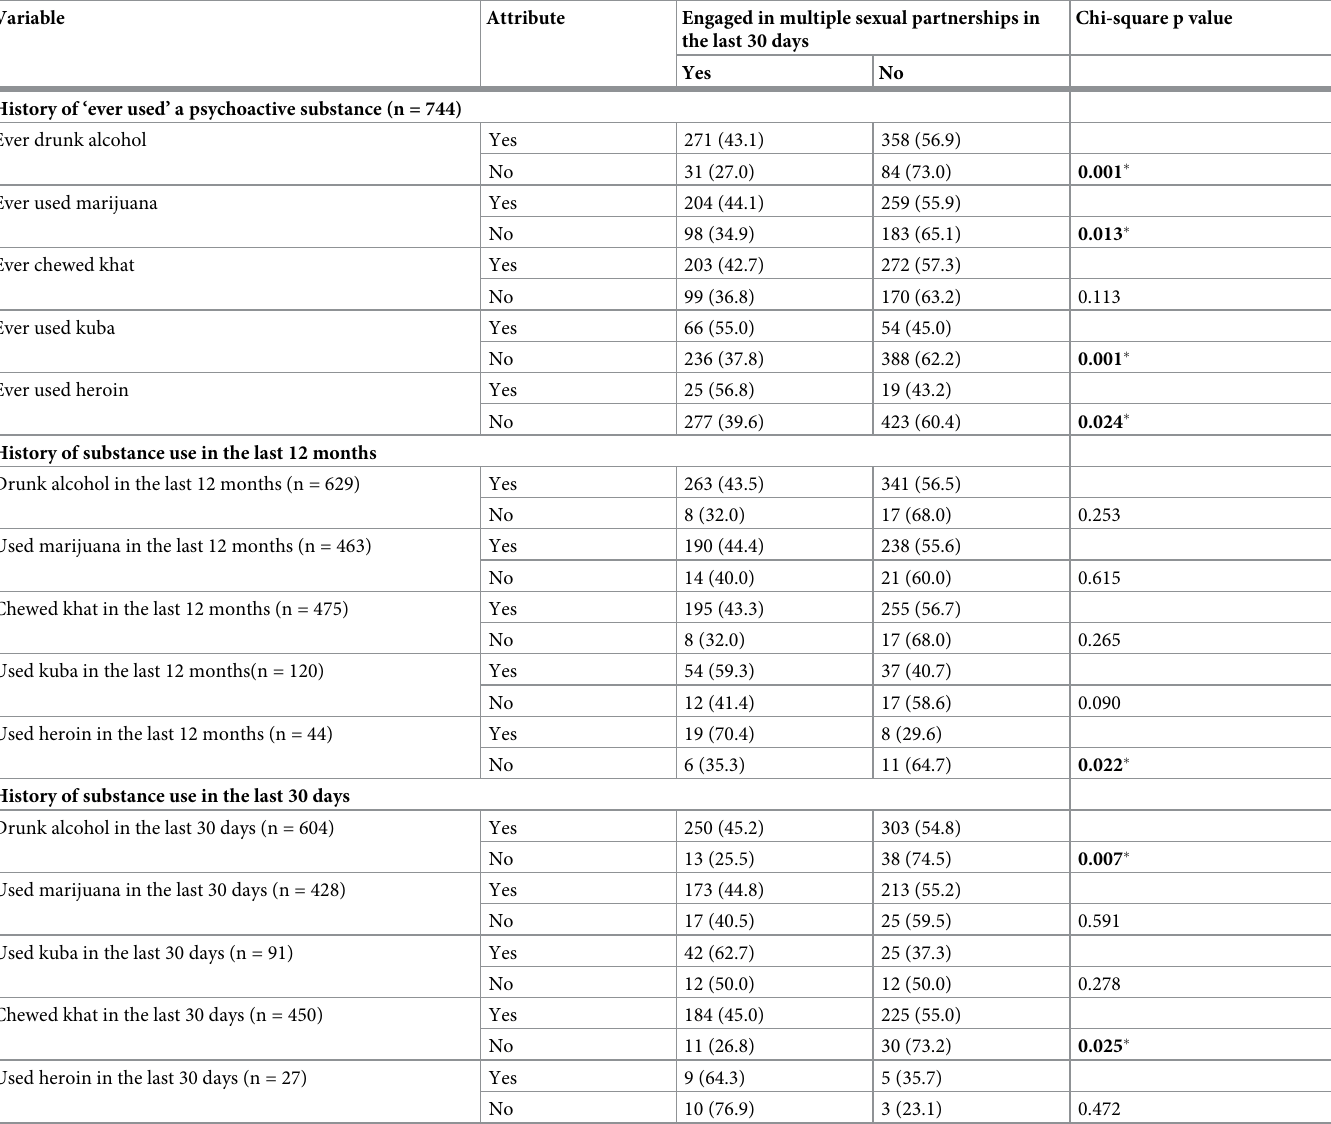
Table 3. Prevalence of multiple sexual partnerships among young psychoactive-substance-users in informal settlements in Kampala.